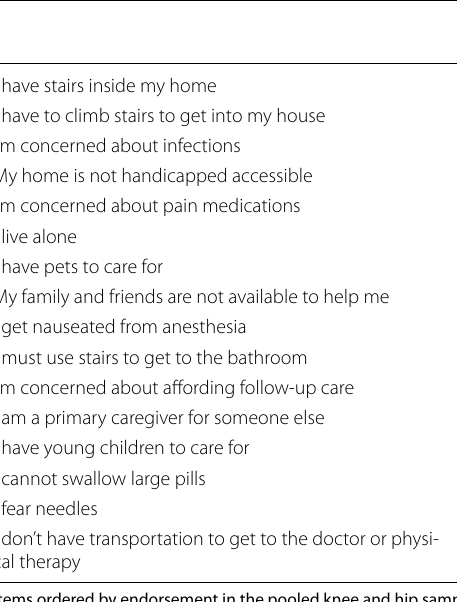
Table 5 Issues affecting patients